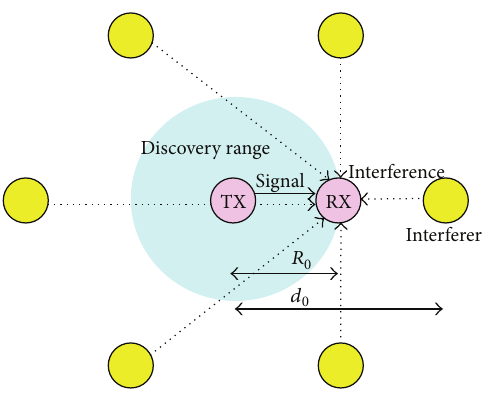
Figure 2: Interference with a hexagonal